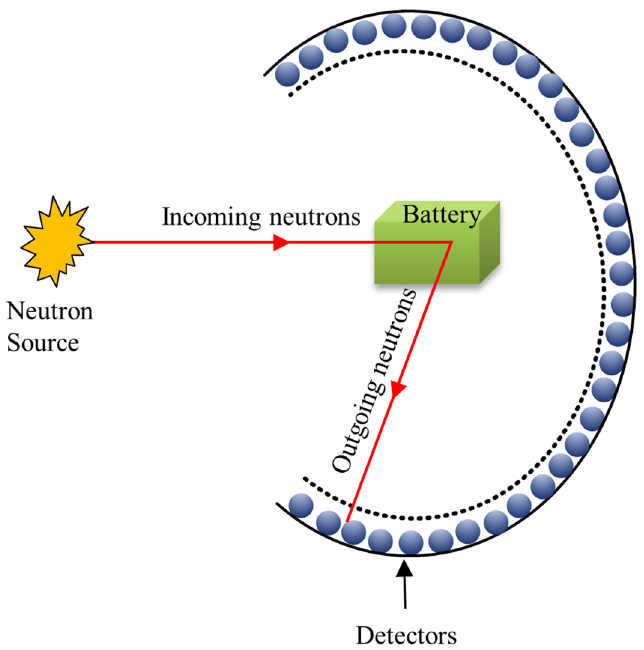
Figure 4. Schematic experimental set-up of in situ/Operando NPDF (adapted with permission from Ref. [45]. 2019 The Royal Society of Chemistry).